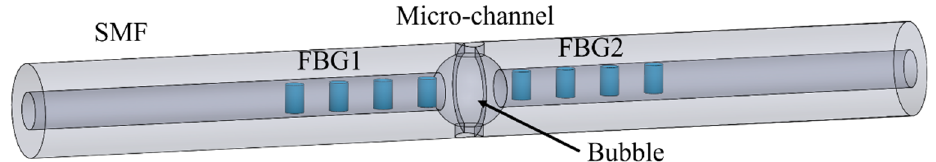
Figure 10. Schematic diagram of the designed PS-FBG in single-mode fiber.